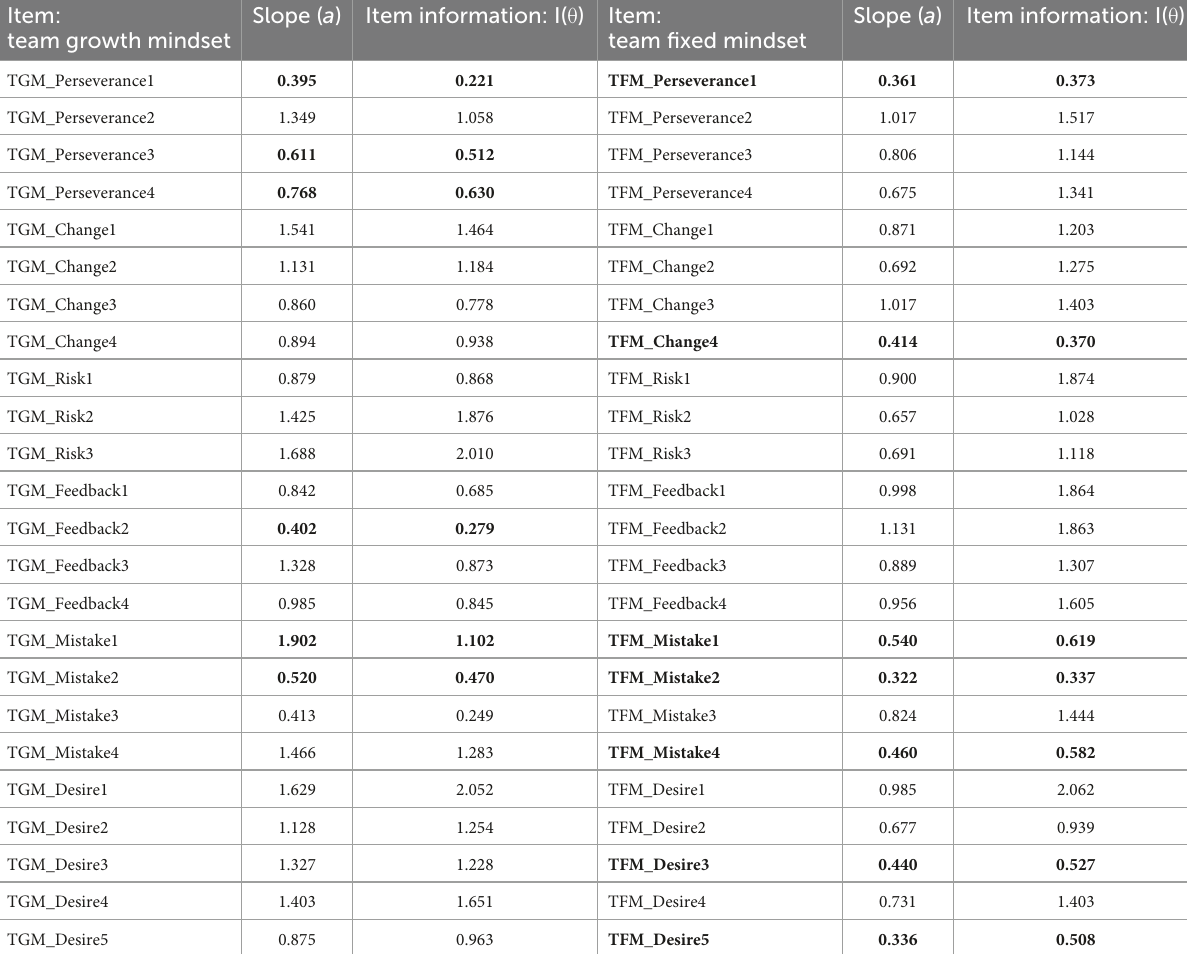
TABLE 3 Item response theory (IRT) item parameters for 24 items on team growth and fixed mindset. Item: Slope ( a ) Item information: I( θ ) Item: team growth mindset